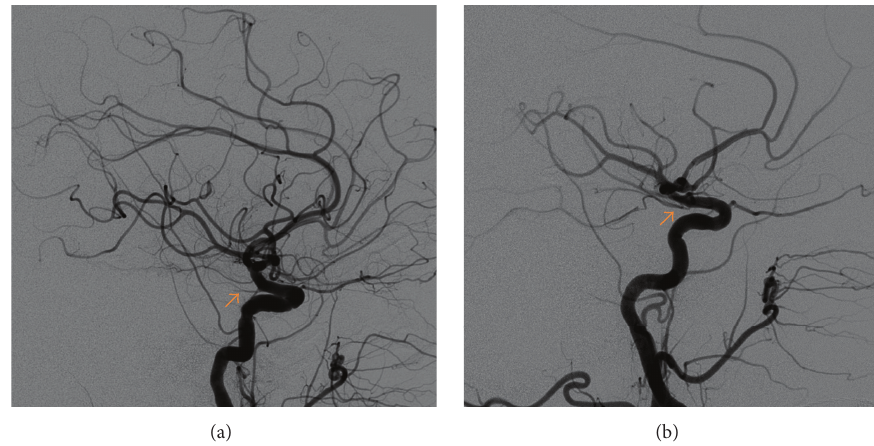
Figure 3: RICA (a) and LICA (b) demonstrating small-sized posterior communicating arteries (arrows).